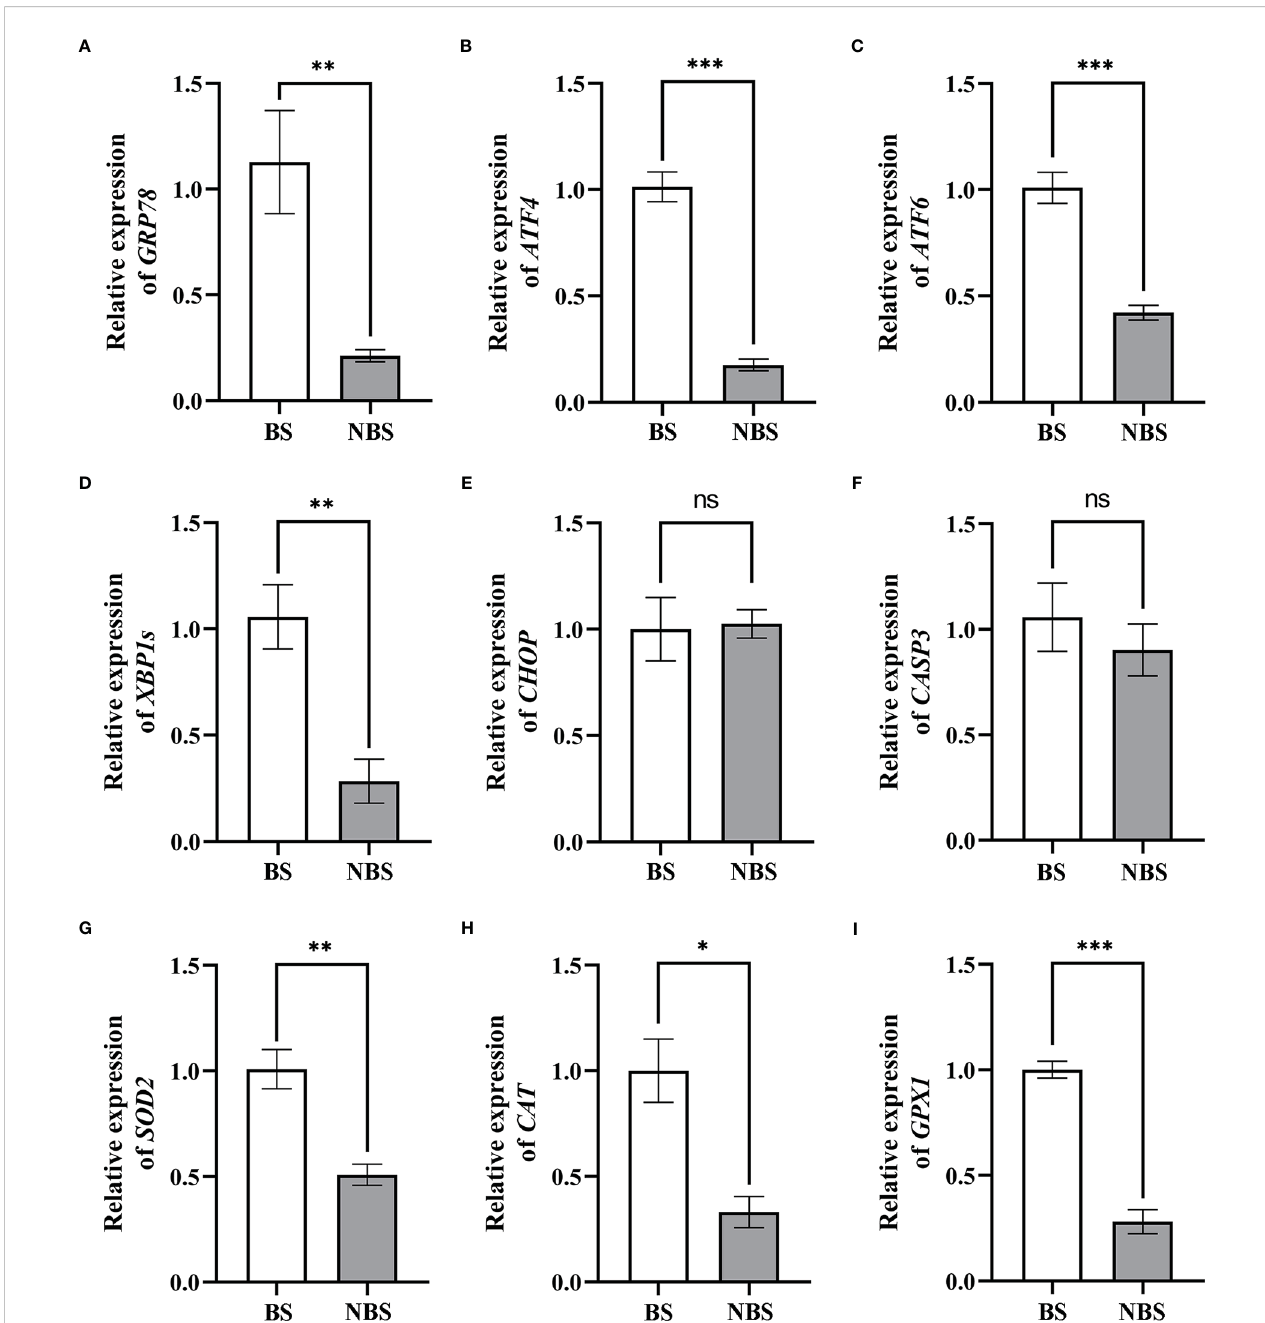
FIGURE 6 The mRNA seasonal expressions of GRP78 (A) , ATF4 (B) , ATF6 (C) , XBP1s (D) , CHOP (E) , CASP3 (F) , SOD2 (G) , CAT (H) , and GPX1 (I) in the ovaries of the muskrats. BS, the breeding season; NBS, the non-breeding season. The sample number is 3 for each group. The error bars represent means ± SEM. Signi fi cance is indicated by * P < 0.05, ** P < 0.01, *** P < 0.001, and ns, not signi fi